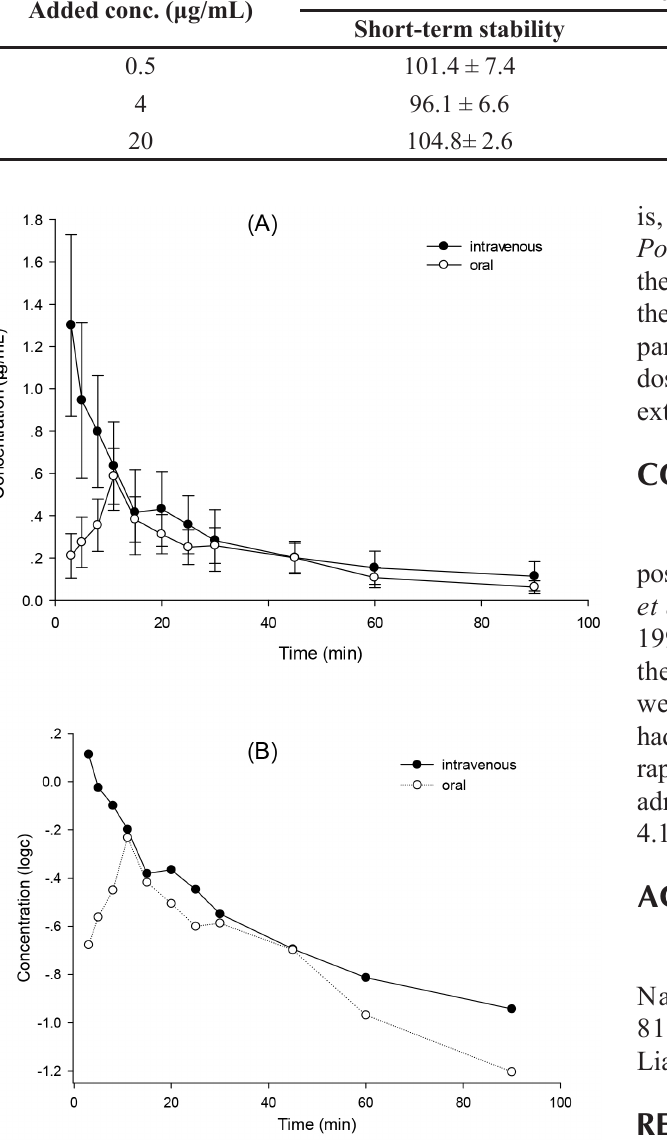
TABLE III - Stabilities of hydroxydihydrobovolide in rat plasma at three QC levels ( n = 5) Added conc.